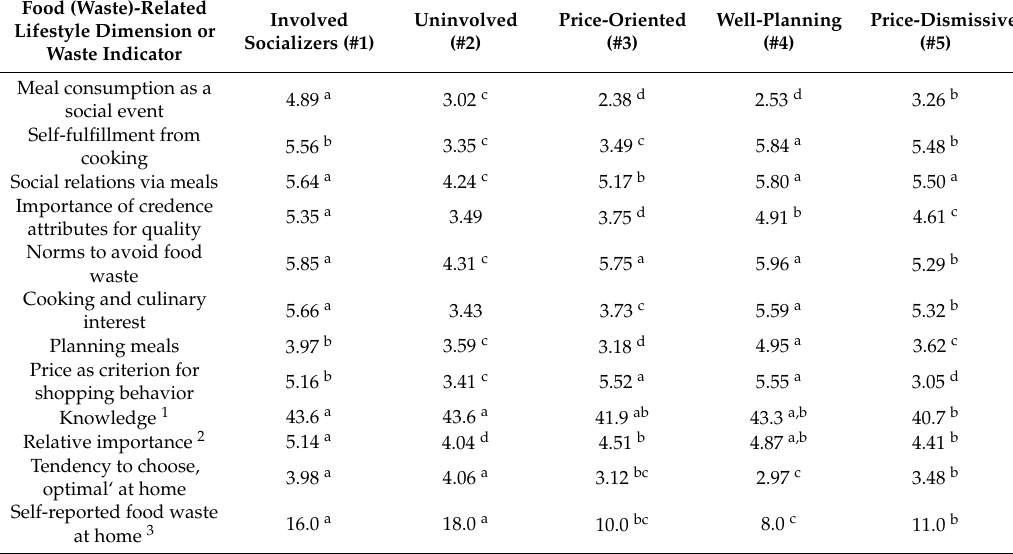
Table 2. Examples of the characterization of food (waste)-related consumer lifestyle segments (#1–#5) and differences in food waste and food waste-related